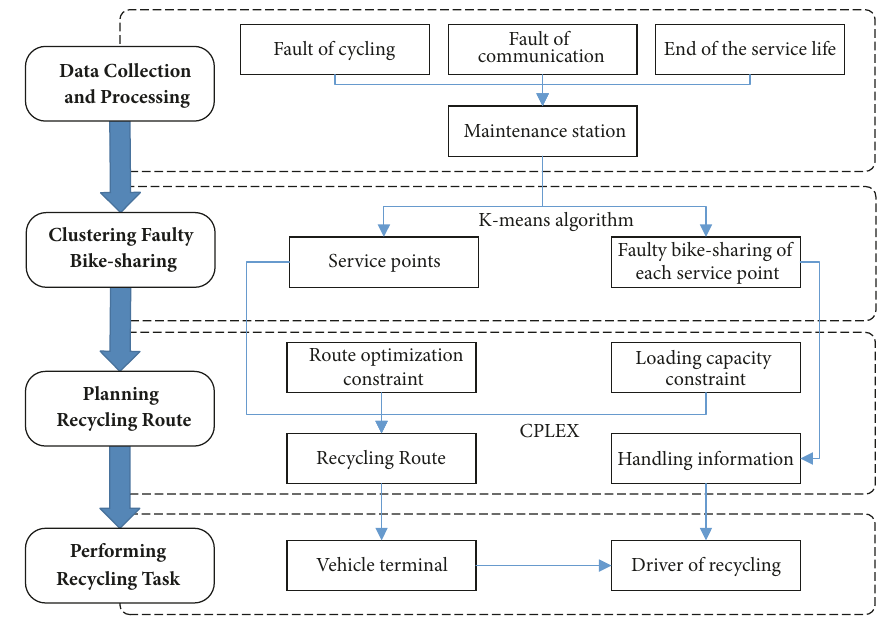
Figure 3: Flowchart of faulty bike-sharing